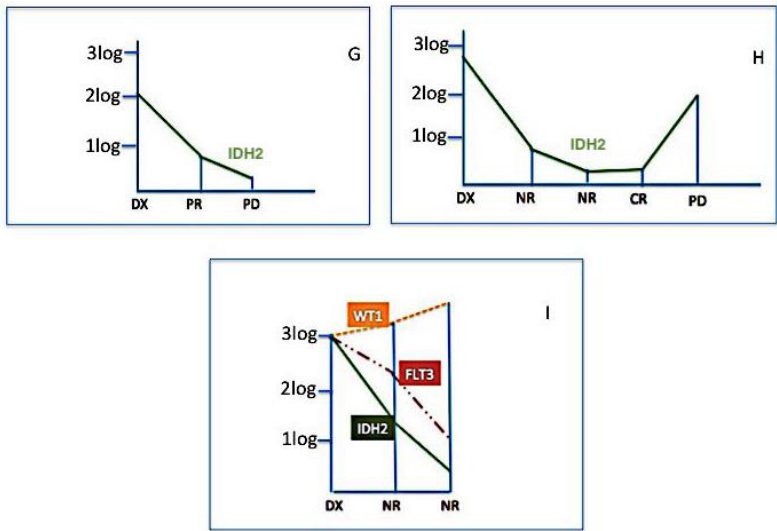
Figure 4. IDH2 mutation monitoring in disease progression (PD). These represent two cases (#E and #F) where MRD has been monitored by Wilms' tumour 1 (WT1) gene expression (orange line), Nu- cleophosmin 1 (NPM1) mutational burden (red line), and IDH2 (green line). In both cases, all three markers (IDH2 = green line) presented the same trend, predicting the loss of response. Moreover, in these patients, IDH2 might be considered as a good marker for MRD.